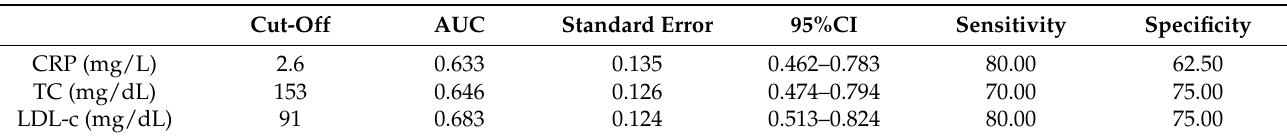
Table 4. Area under the receiver operating characteristic (AUC ROC) curves of our 3 investigated markers: CRP, TC, and LDL-c.